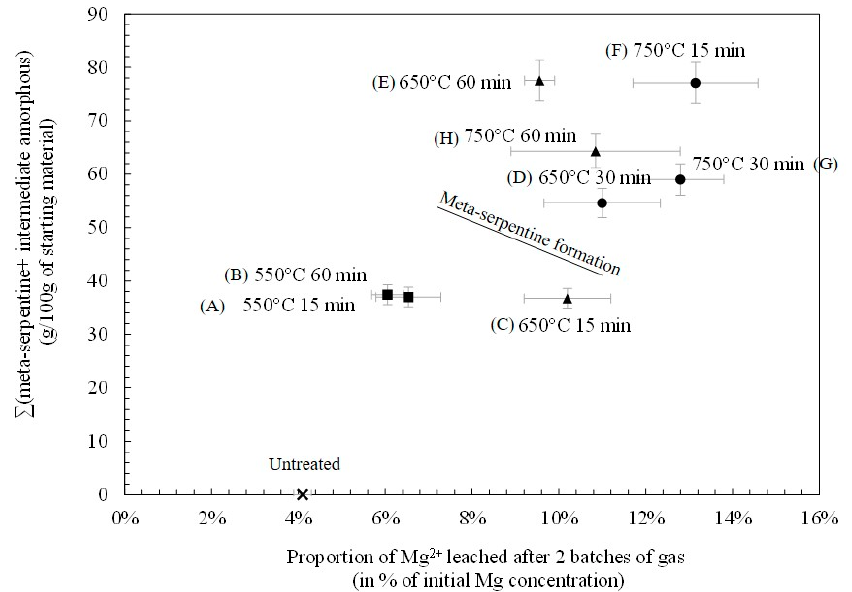
Figure 3. Extracted plotted against the quantity of amorphous phases, being the sum of the intermediate amorphous components and meta-serpentine. (Squares, triangle, and circles stands for test temperature of 550 °C, 650 °C, and 750 °C, respectively).